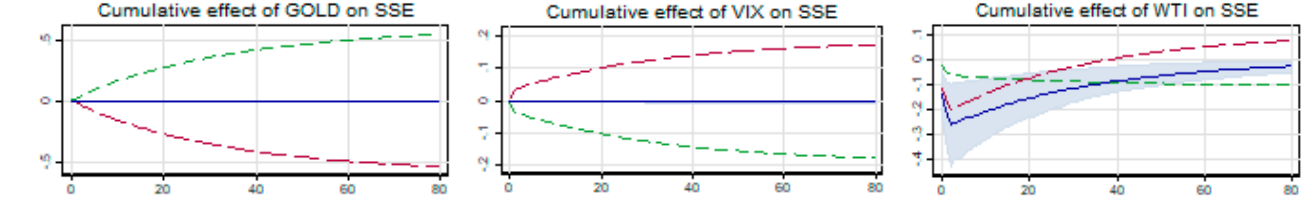
Figure 4. Cumulative effects of cryptos and gold on SSE.